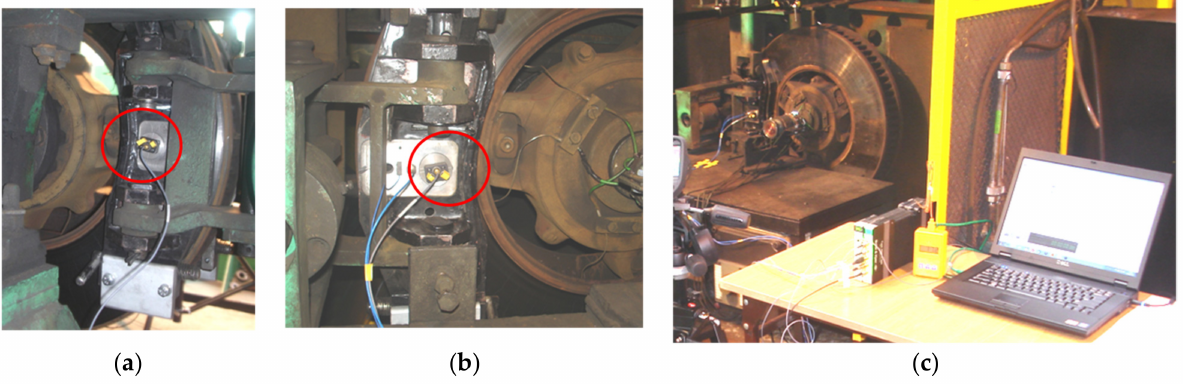
Figure 4. The tested brake disc mounted on the brake stand for testing railway disc brakes: ( a ) view of the left friction pair—brake disc with lining and attached vibration transducer, ( b ) view of the right brake holder and attached vibration transducer, ( c ) view of the stand with vibration measurement